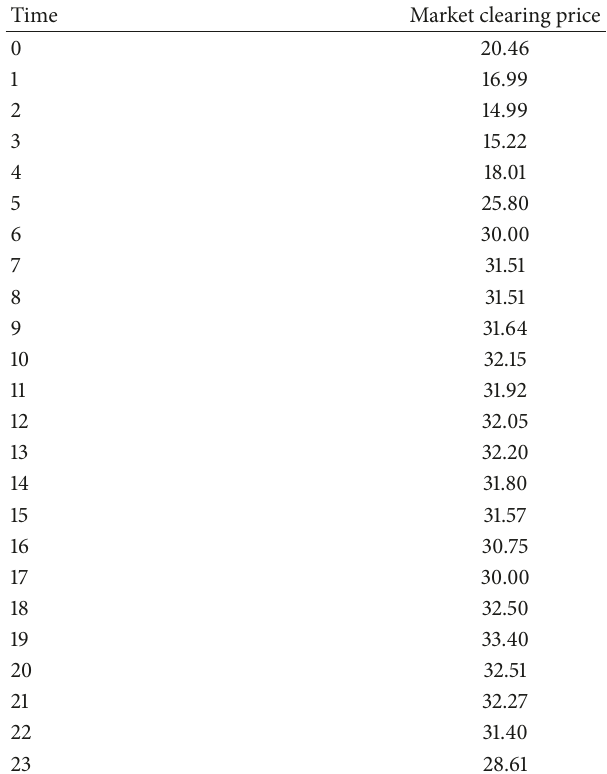
Table 1: Market clearing price for a typical month in PJM electricity